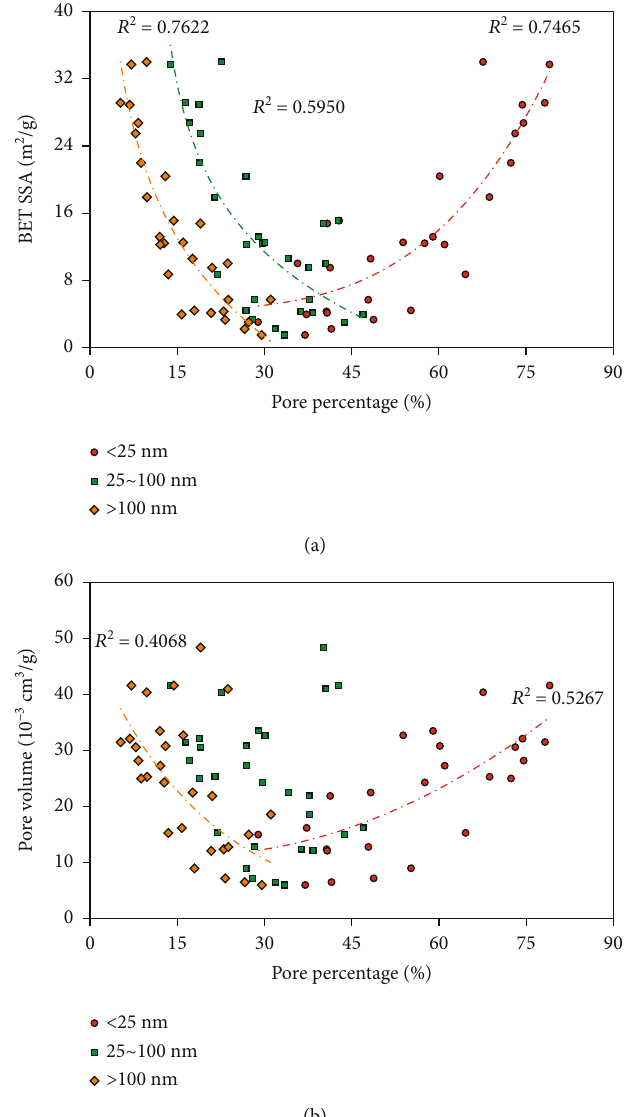
Figure 7: Relationships between speci fi c surface area (a) and pore percentages and the relationships between pore volume (b) and pore